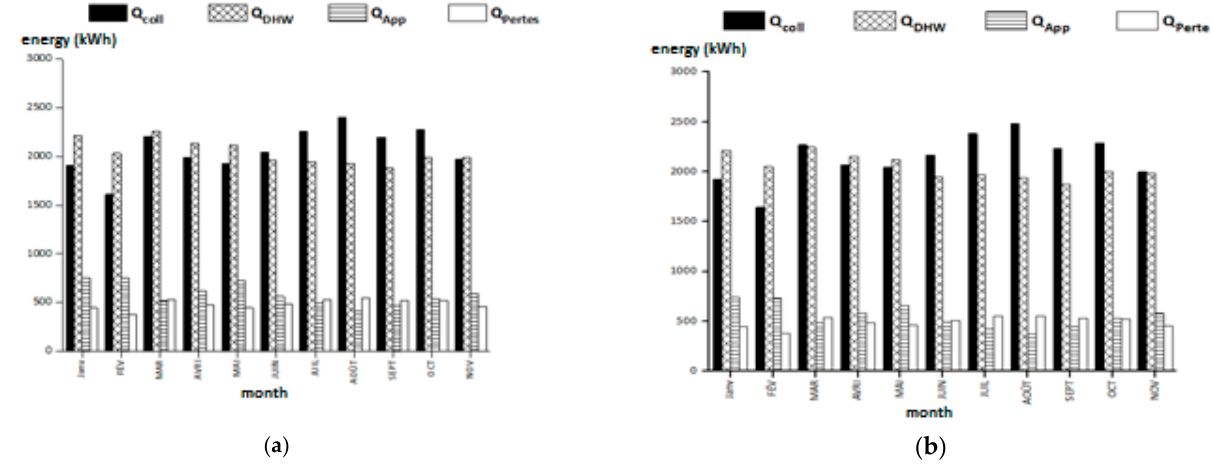
Figure 11. ( a ) Flat plate collector, ( b ) evacuated tube collector.